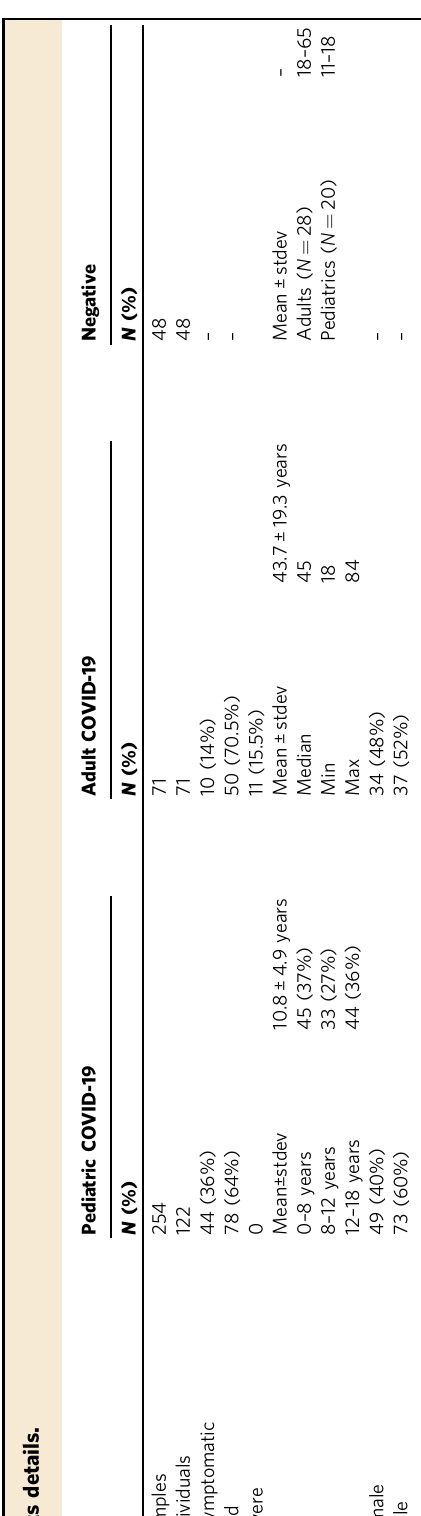
pediatric COVID-19 samples compared to adults ( p < 0.0001, Fig. 2g). In terms of performance as a diagnostic test, ORF8 antibodies by LIPS allows for the detection of nearly all the pediatric population with a sensitivity of 99.2% and speci fi city of 100% (Fig. 2g). These results were then con fi rmed in an in-house ELISA assay for IgG binding using recombinant proteins in both adult and pediatric plasma samples, where ORF8-protein 35 binding antibodies showed 79% sensitivity and 98.4% speci fi city (Supplementary Fig. 1c), whereas N and Spike-protein binding antibodies showed a sensitivity of 88% and 11% and a speci fi city of 97% and 99%, respectively (Supplementary Fig. 1d, e). Furthermore, ORF8 remains a speci fi c diagnostic tool for SARS-CoV-2 infection in vaccinated conditions. ORF8 speci fi c IgG was assessed following vaccination with whole inactivated virion Coronavac and Spike mRNA lipoprotein BNT162b2 (Supplementary Fig. 1f), showing ORF8 is likely not incorporated within the virion. We then compared the cumulative SARS-CoV-2 antibody responses from asymptomatic/mild only COVID-19 children and adult in a heatmap (Fig. 2i) and as percentages of the total SARS-CoV-2 structural and accessory antibody response (Fig. 2j). Due to the immunodominant effect of the N protein, anti-N antibodies substantially dominate the SARS-CoV-2 humoral response detected by LIPS in both populations (Fig. 2i), which is consistent with our previous fi ndings in the adult population 24 . There was a signi fi cant difference in the distribution of the overall speci fi city of pediatrics and asymptomatic/mild COVID-19 adults ( p < 0.0001 for “ observed ” pediatric distribution compared with “ expected ” adult distribution, Fig. 2j, Supplementary Fig. 1a, Supplemen- tary Table 3). In the adult population antibody levels of S1, M, ORF3a and ORF7b represented a higher percentage of the response in adults than children (Fig. 2j and Supplementary Fig. 1a). While, ORF8 and E antibody responses represented a higher percentage in the pediatric population with 13.4% versus 9.2% and 11% versus 4.8%, respectively (Fig. 2j and Supplementary Fig. 1a). The remaining antigens, S2, S2 ′ , N, NSP1, ORF3d, ORF6, ORF7a, ORF10, represent a similar percentage in both populations and hence are not contributing to the differences observed in speci fi city. Furthermore, there are no differences in total IgG serum concentration with age or infection, despite differences in the magnitude and speci fi city of SARS-CoV-2 antibodies in adults versus children (Supplementary Fig. 1b). 1 8 – SARS-CoV-2 antibody speci fi city using clusters of points and principal component analysis . A cluster of points depicts each individual sample in a more complete way than a classical single statistical comparison, as it considers a combination of three (or more) different parameters taken together and the relevant rela- tions of these parameters. To decipher the SARS-CoV-2 antibody speci fi city in children, we used relevant antibody combinations to represent the COVID-19 pediatric samples in clusters of points relative to negative controls and COVID-19 adult populations (Fig. 3a – c and Supplementary Fig. 2). First, the cluster representing the three antibodies to the S subunit antigens S1, S2 ′ , S2 con fi rmed that the pediatric population has a S antibody pro fi le that is more closely comparable to negative controls (Fig. 3a) than an adult COVID-19 response by LIPS (Fig. 3b). Further cluster analysis of antibodies to other structural proteins N, M, and E reveals that the COVID-19 children population appears to be quite heterogeneous with a large range in response magnitude compared to adults (Supplementary Fig. 2b, c). Despite having a a different pro fi le than both the adult COVID-19 and the negative T